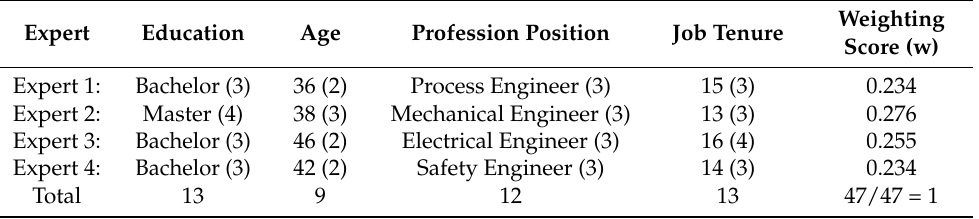
Table 2. Expert weighting of the group decision-making for the present